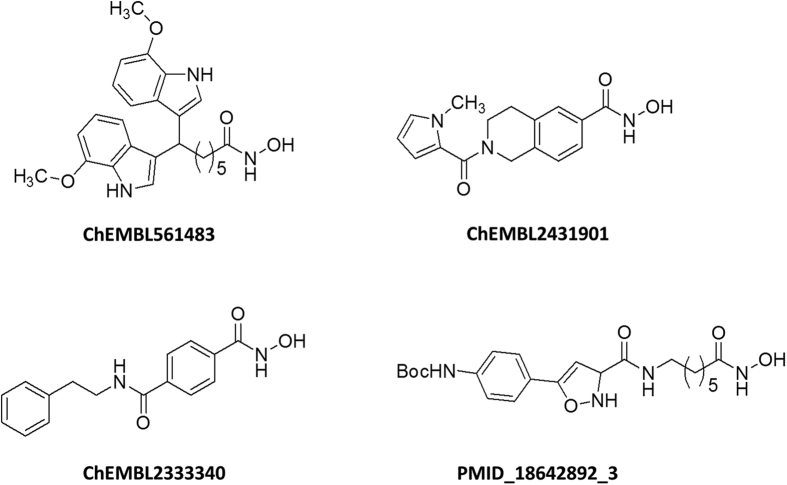
Chemical structures of compounds selected for pharmacophore generation.The structure of the most potent HDAC6 inhibitor (PMID_18642892_3) reported in the literature is also presented.